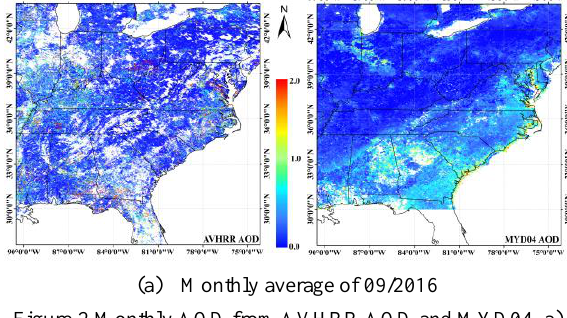
Figure 2 Monthly AOD from AVHRR AOD and MYD04. a) AVHRR AOD and b) MYD04 C6 DDV algorithm.